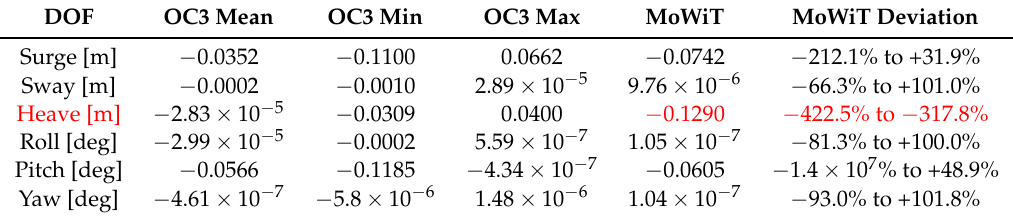
Table 11. Static equilibrium positions from OC3 and MoWiT in comparison, deviations are highlighted in